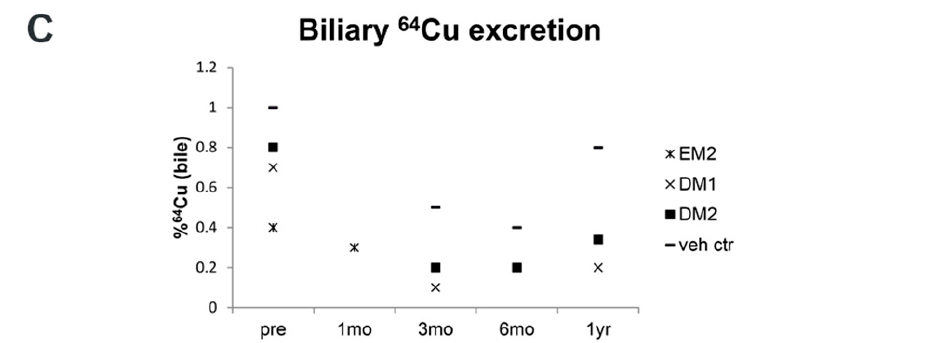
Figure 5. Proliferation and di ff erentiation of transplanted cells in vivo. Double immunohistochemical staining was performed on liver sections post-transplantation to investigate the presence of proliferation marker Ki67 and di ff erentiation marker MRP2 on transplanted cells. ( A ) Transplanted cells were sporadically positive for Ki67 (arrow), but only in sections one week after transplantation and not at later time points. ( B ) Transplanted cells did not show immunostaining for MRP2, whereas hepatocytes showed positive canalicular staining. 1 wk: one week (dog EM1); 1 mo: one month (dog EM2); 1